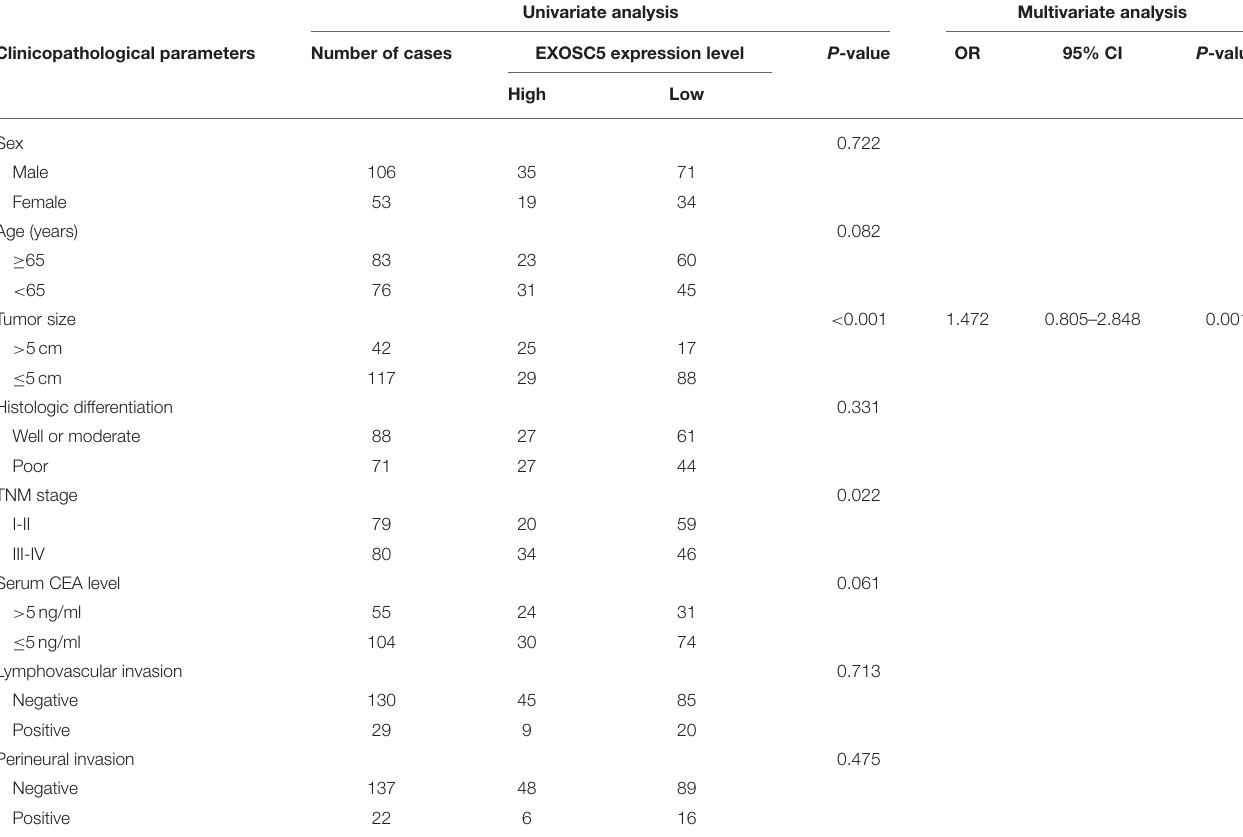
TABLE 1 | Correlation between EXOSC5 expression and the clinicopathological parameters of 159 CRC patients.